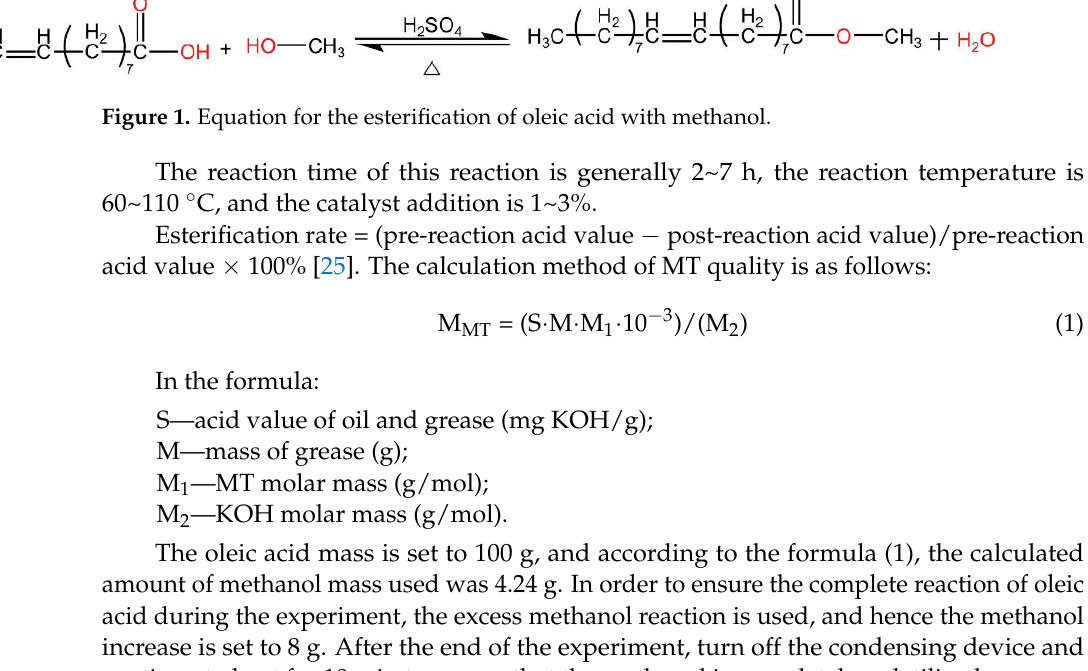
Figure 2. Catalytic esterification results of different catalysts ( a ): concentrated sulfuric acid; ( b ): so- dium hydroxide; and ( c ): sulfamic acid.